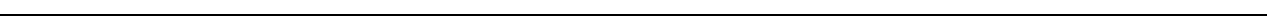
Fig. 1 Characterization of Oxtr expression in anterior hippocampus. a Representative low-magni fi cation (left) and high-magni fi cation (right) images of Oxtr and Gad1 mRNA expression in anterior DG by FISH ( n = 4 males, 3 females). Asterisk (*) denotes Oxtr + /Gad1 + interneuron. Arrowhead ( > ) denotes Oxtr + /GAD1 − mossy cell. Scale bar, 100 μ m. Inset scale bar, 50 μ m. b Quanti fi cation of Gad1 and Oxtr colocalization for males and females, expressed as a percentage of Gad1 + cells over total Oxtr + cells. c Representative images of low-magni fi cation (left) and high-magni fi cation (right) images of Oxtr , PV , and SST mRNA expression in anterior DG by FISH ( n = 4 males, 3 females). Asterisk (*) denotes PV + /Oxtr + interneuron. Right-facing arrowhead ( > ) denotes Oxtr + mossy cell. Upward facing arrowhead (^) denotes Oxtr + /SST + interneuron. Scale bar, 100 μ m. Inset scale bar, 50 μ m. d Quanti fi cation of Oxtr colocalization with PV and SST , expressed as a percentage of total Oxtr cells. e Representative low-magni fi cation (left) and high-magni fi cation (right) images of Oxtr and Gad1 mRNA expression in aCA3 proximal by FISH ( n = 4 males, 3 females). Scale bar, 100 μ m. Inset scale bar, 50 μ m. f Quanti fi cation of mean Oxtr intensity for CA regions expressed in arbitrary units, normalized for background. g Representative low-magni fi cation (left) and high- magni fi cation (right) images of Oxtr and Gad1 mRNA expression in aCA2/CA3 distal by FISH ( n = 4 males, 3 females). Asterisk (*) denotes Oxtr + /GAD1 + interneuron. Scale bar, 100 μ m. Inset scale bar, 50 μ m. h Quanti fi cation of Gad1 and Oxtr colocalization in aCA2/CA3 distal for males and females, expressed as a percentage of Gad1 + cells over Oxtr + cells. i Representative images of Oxtr , PV , and SST mRNA expression in aCA2/CA3 distal by FISH ( n = 4 males, 3 females). Asterisk (*) denotes PV + /Oxtr + interneuron. Scale bar, 50 μ m. Inset scale bar, 25 μ m. j Quanti fi cation of Oxtr colocalization with PV and SST in aCA2/CA3 distal , expressed as a percentage of total PV cells (top) or SST cells (bottom). k Representative low-magni fi cation (left) and high-magni fi cation (right) images of Oxtr and Gad1 mRNA expression in aCA1 by FISH ( n = 4 males, 3 females). Scale bar, 100 μ m. Inset scale bar, 50 μ m. l Schematic of anterior and posterior hippocampal subregions